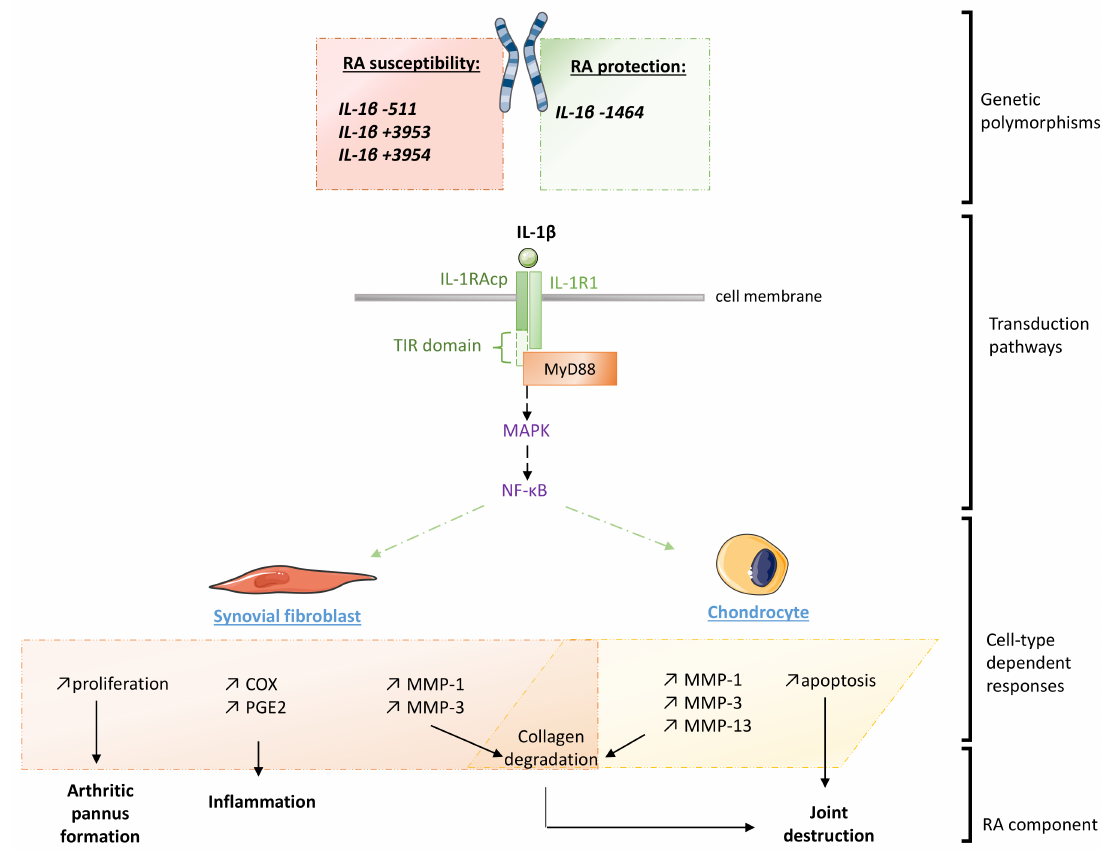
Figure 1. Schematic representation of the different levels of IL-1 β ’s implication in the pathogenesis of rheumatoid arthritis (RA). IL-1R1: Interleukin-1 type-I receptor; IL-1RAcP: IL-1 receptor accessory protein; MAPK: Mitogen-activated protein kinase; MMP: Matrix metalloproteinase; MyD88: Myeloid and differentiation primary response 88; NF- κ B: Nuclear factor- κ B; PGE2: Prostaglandin E2; TIR: Toll-IL-1